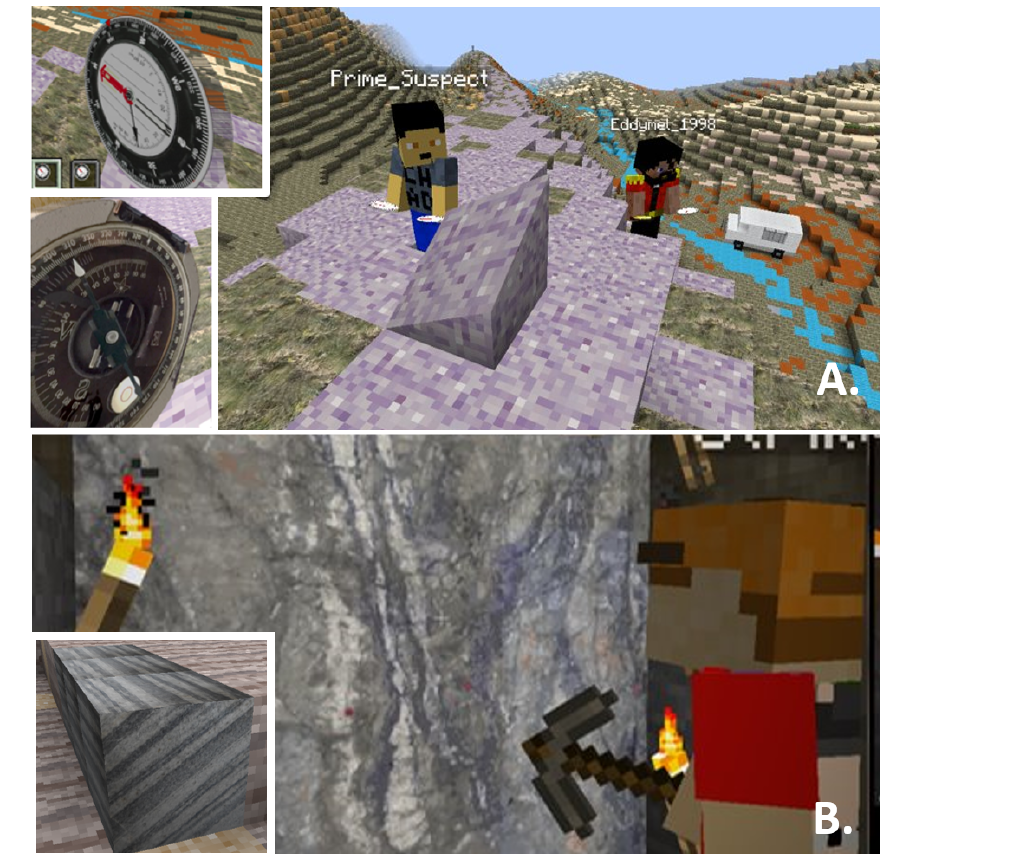
Figure 1. A composite image with panel (a) showing custom compass (insert a ) and angled surfaces for measuring strike and dip as well as real photos (b) embedded into the game to provide realistic rock and foliation (insert b ) identification